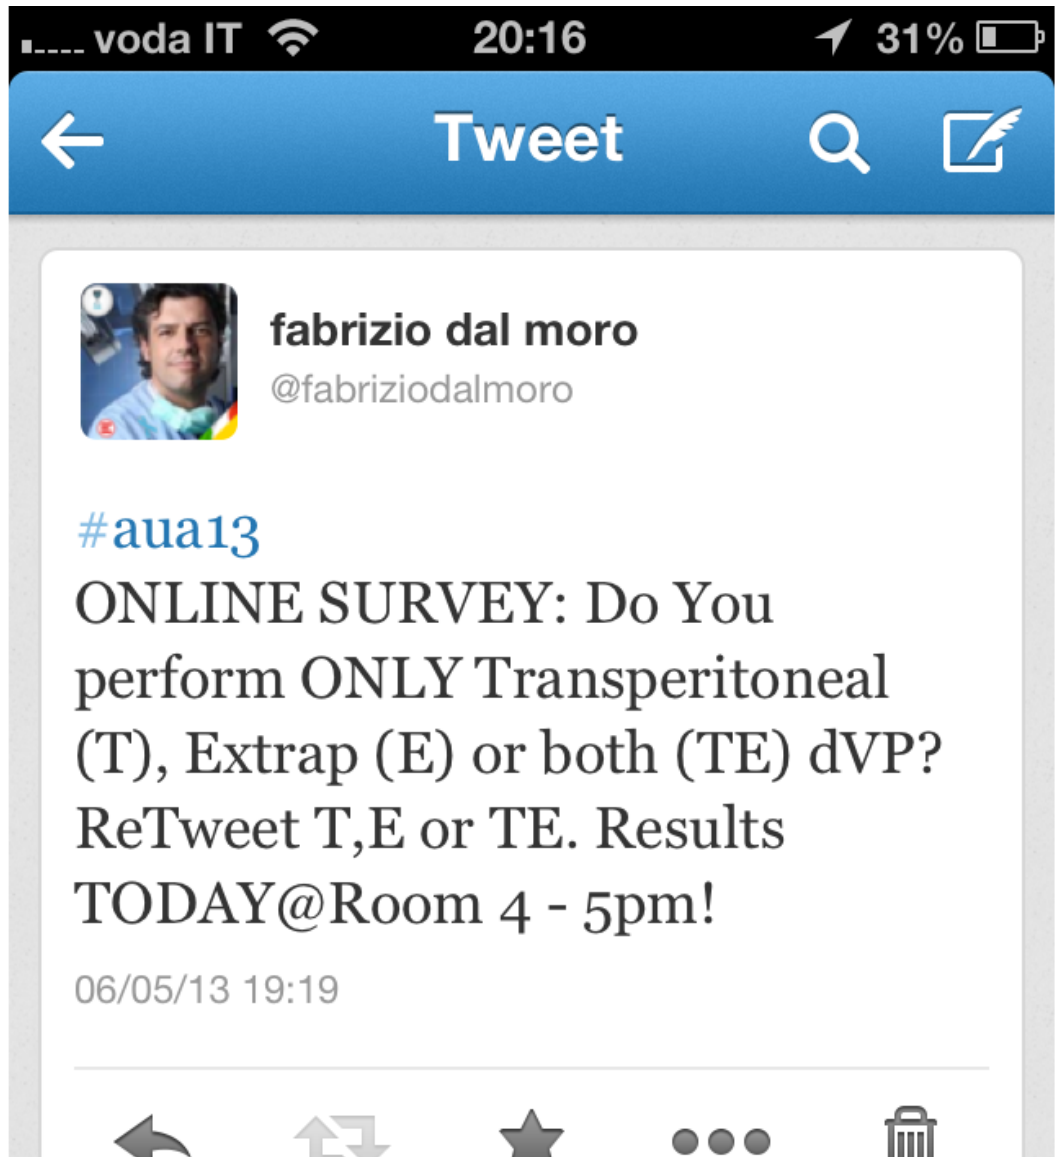
Figure 1. Screenshot of the